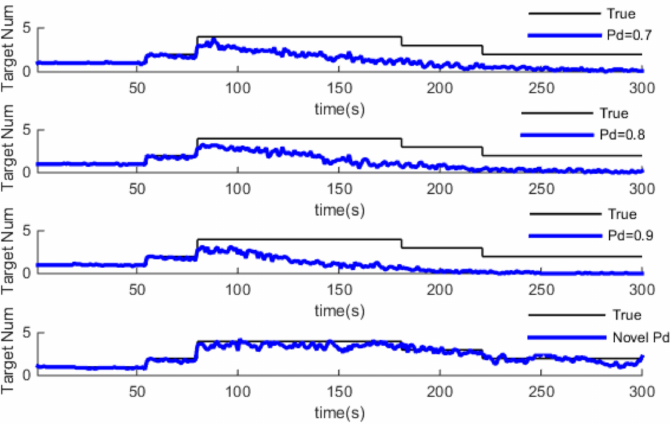
Figure 7. Comparison of target number estimation with different P d in clutter intensity κ k = 10.